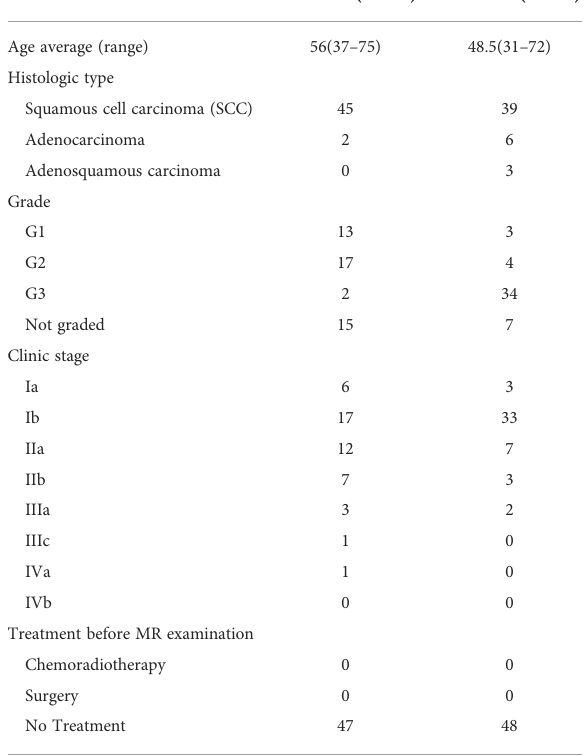
TABLE 2 Cervix cancer patient